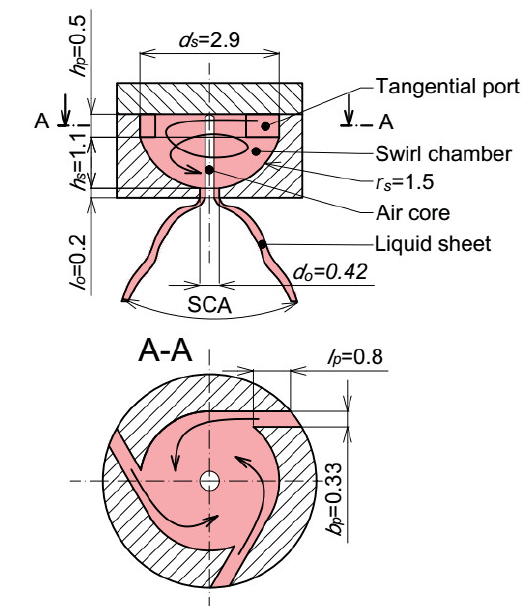
Fig. 1. A sketch of the original atomizer with the main dimensions in mm. The transparent atomizer had all dimensions 10 times